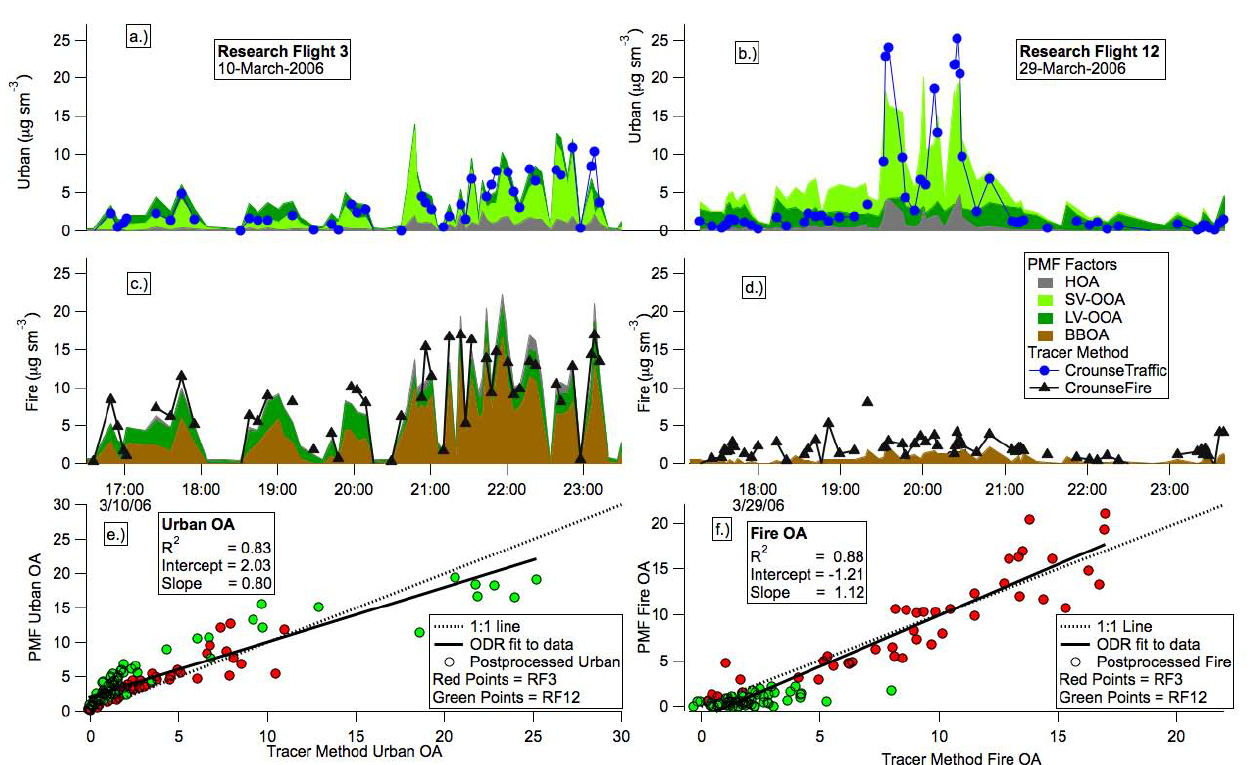
Fig. 9. (a–d) show the RF3 and RF12 comparison to the Crounse et al. (2009) study for the urban OA factor and the fire OA factor. The postprocessed PMF components contribution to urban and fire sources are the solid colors stacked on top of each other. Parts e and f are scatter plots comparing the postprocessed PMF urban OA vs. Tracer method urban OA and the postprocessed PMF fire OA vs the Tracer method fire OA respectively. The points are colored by